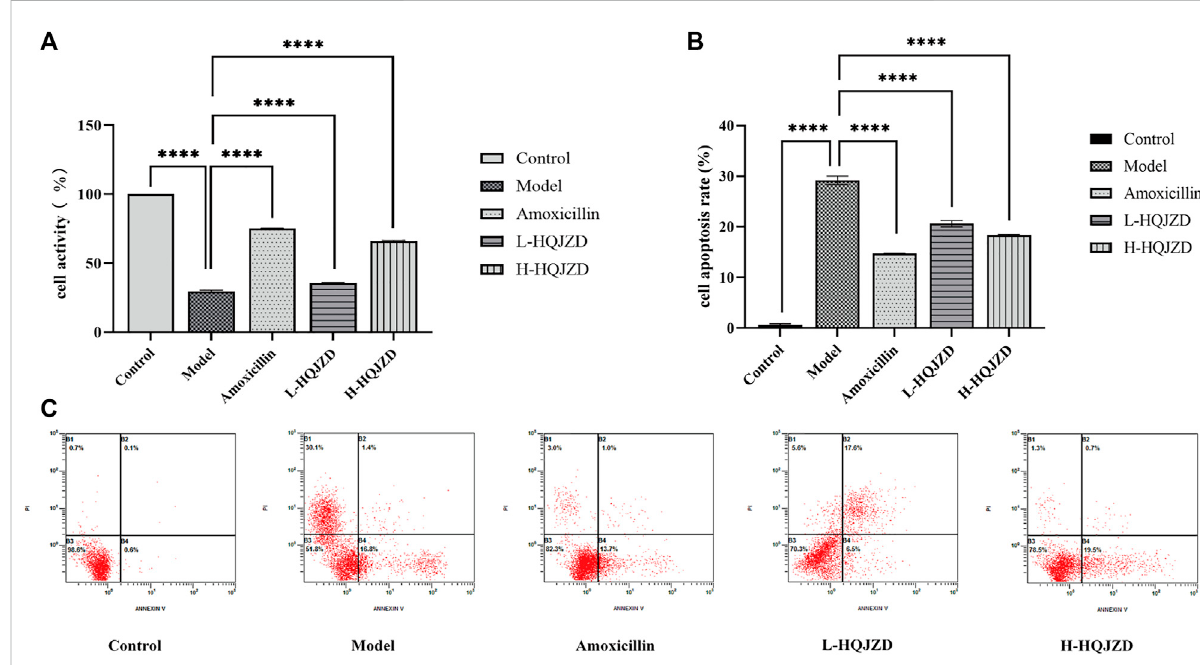
FIGURE 2 Effect of HQJZD on proliferation and apoptosis of GES-1 cells infected with H. pylori . (A) Cell activity of GES-1 cells; (B) cell apoptosis rate of GES-1 cells; and (C) graph of the apoptosis assay of the different